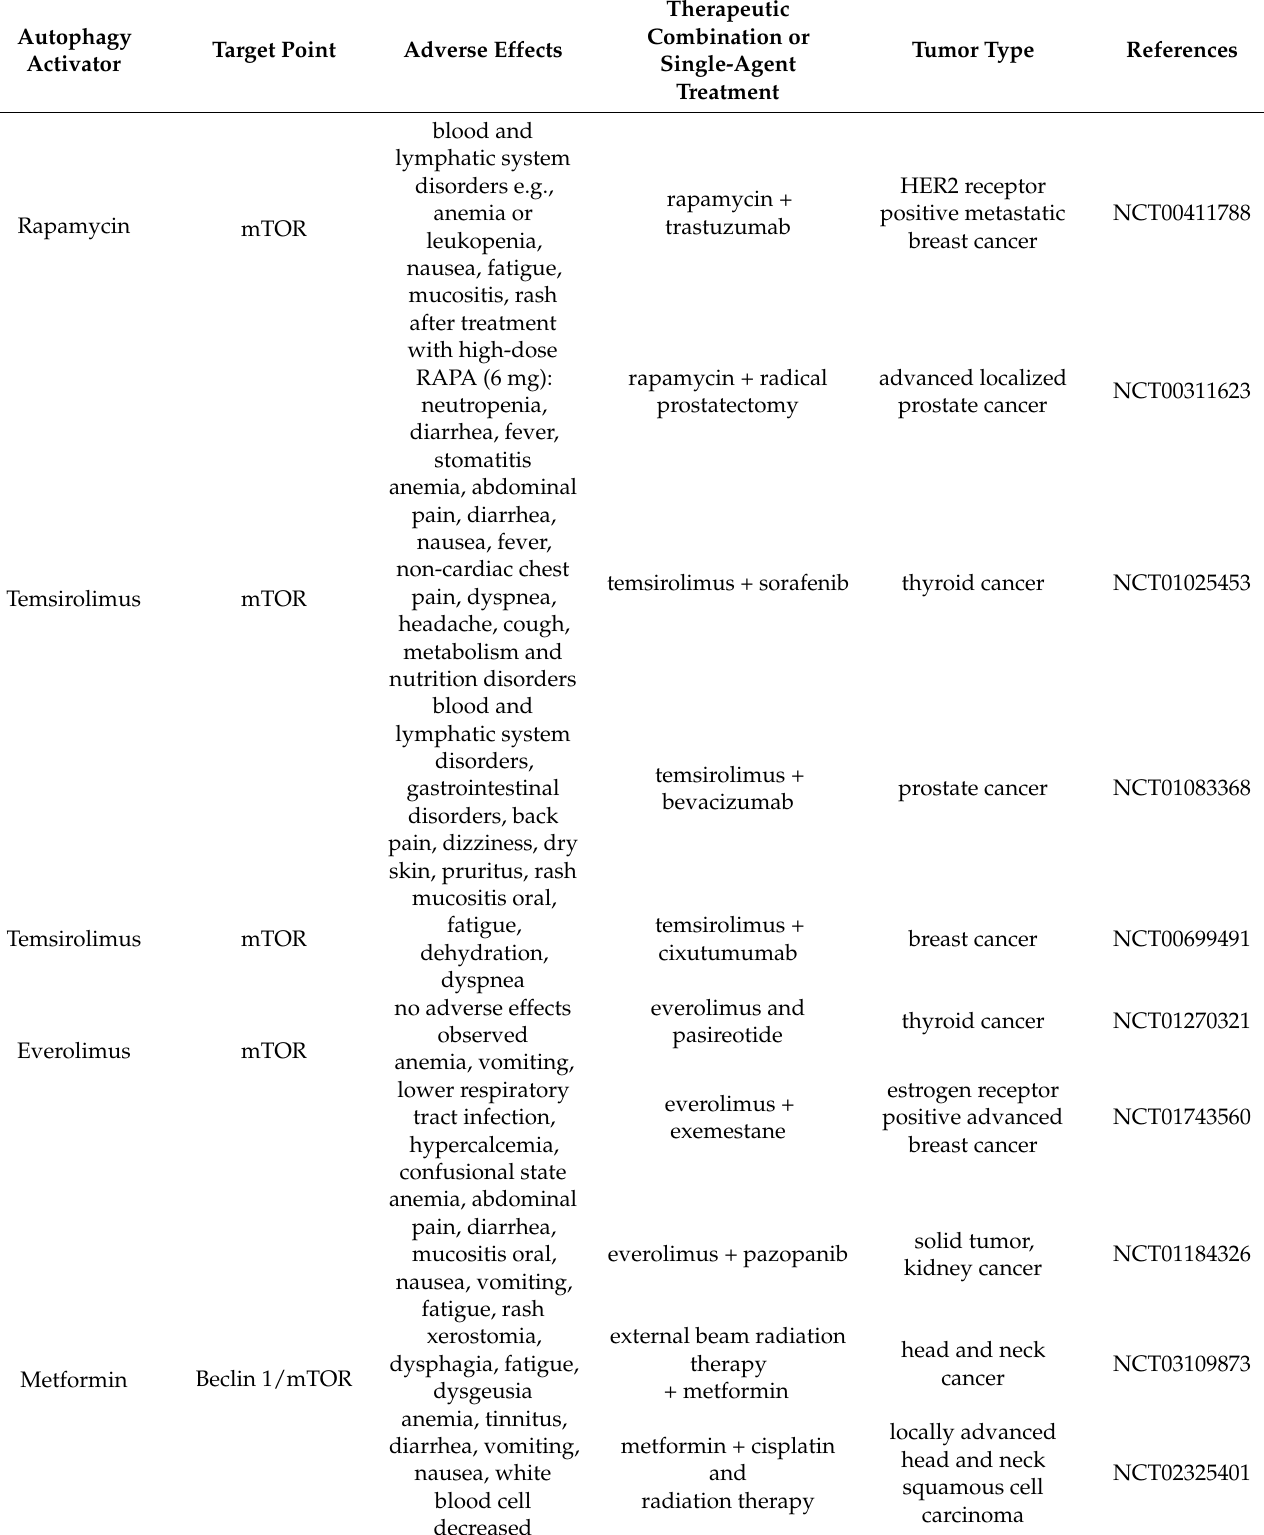
Table 5. Target points, adverse effects and selected therapeutic schemes of autophagy